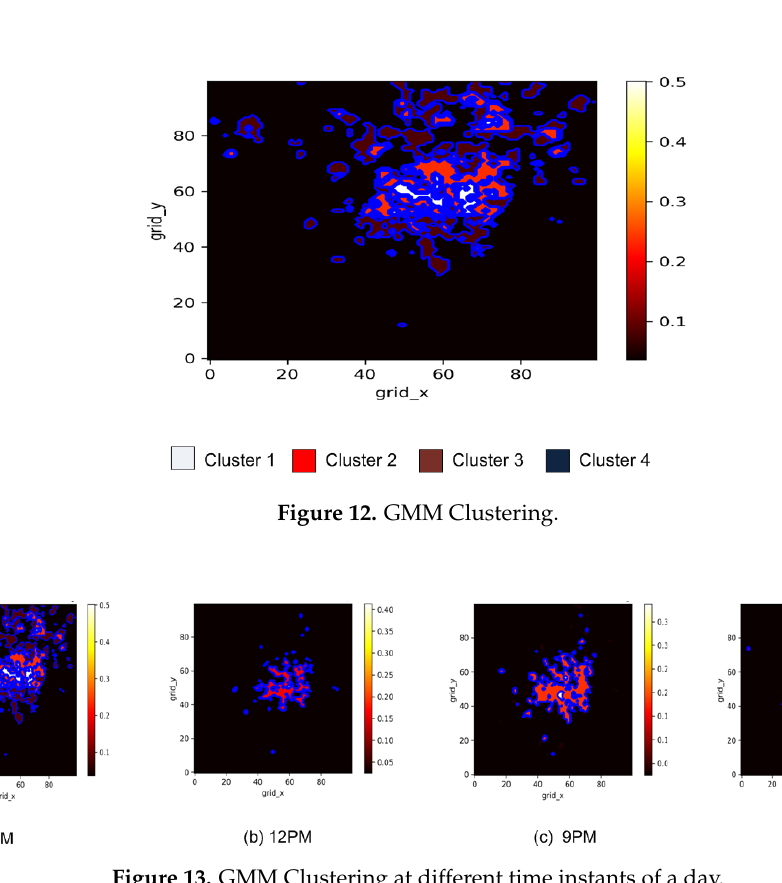
Figure 13. GMM Clustering at different time instants of a